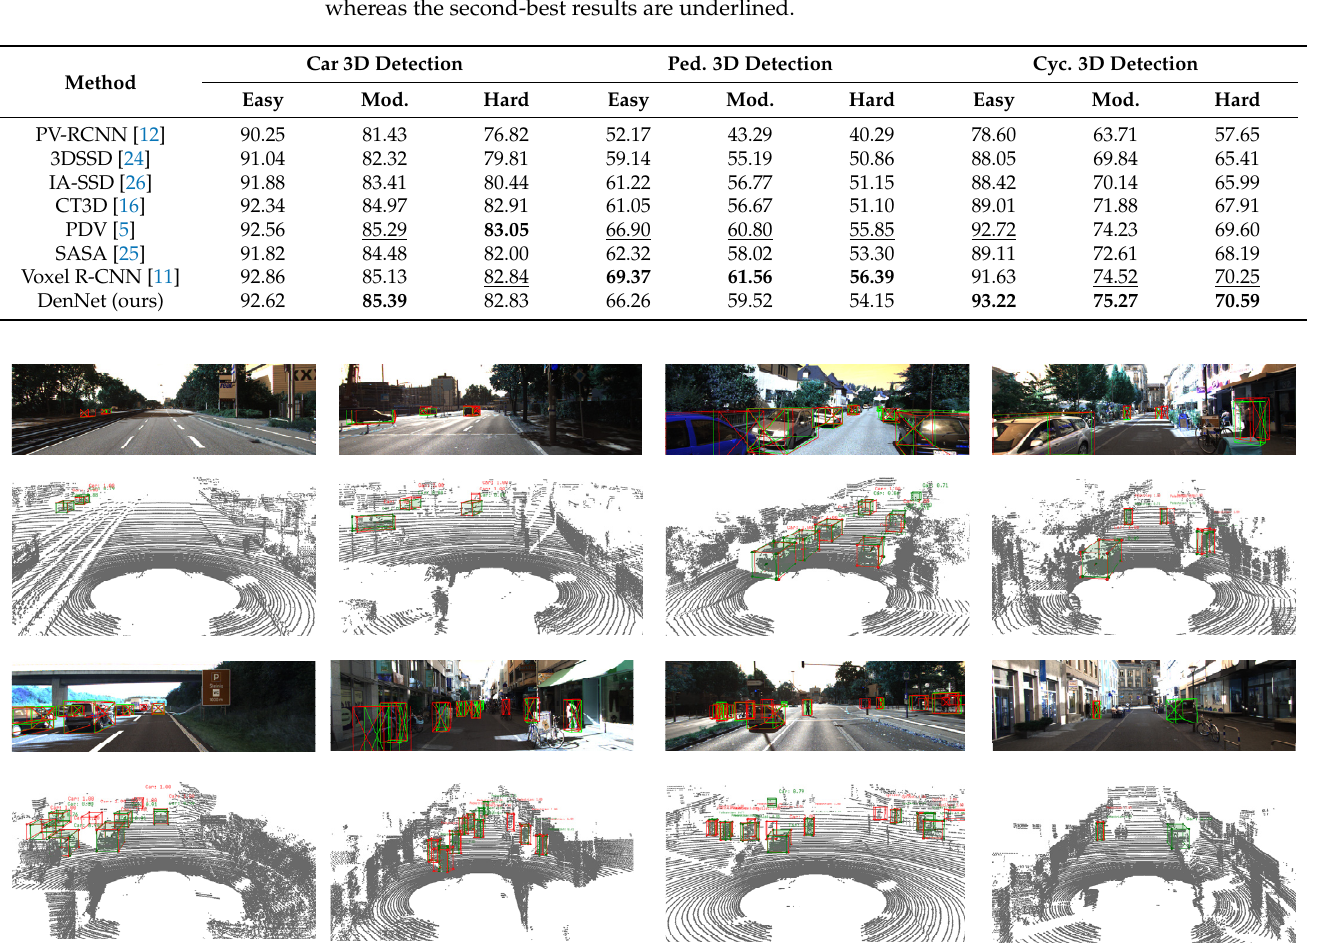
Figure 7. Qualitative results achieved on KITTI validation set. Red boxes represent the ground truth, green boxes denote the prediction results, and the numbers in green represent the confidence of the predictions.